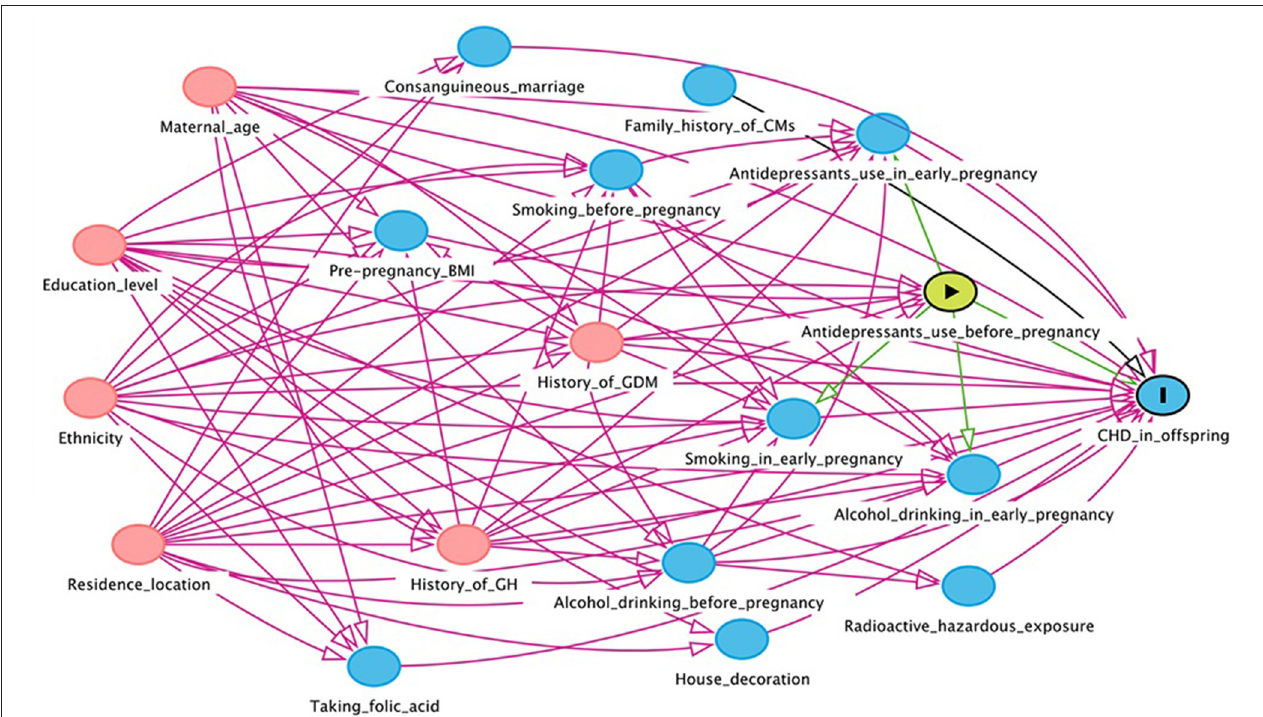
FIGURE 1 | Directed acyclic graph for the association between maternal antidepressant use in 3 months before pregnancy and risk of CHD in offspring. Red arrows indicate biasing paths, green arrows indicate causal paths. Minimal sufficient adjustment sets for estimating the effect of maternal antidepressant use in 3 months before pregnancy on offspring CHD: maternal age, ethnicity, residence location, education level, history of gestational diabetes mellitus and history of gestational hypertension. BMI, body mass index; CHD, congenital heart disease; CM, congenital malformation; GDM, gestational diabetes mellitus; GH, gestational